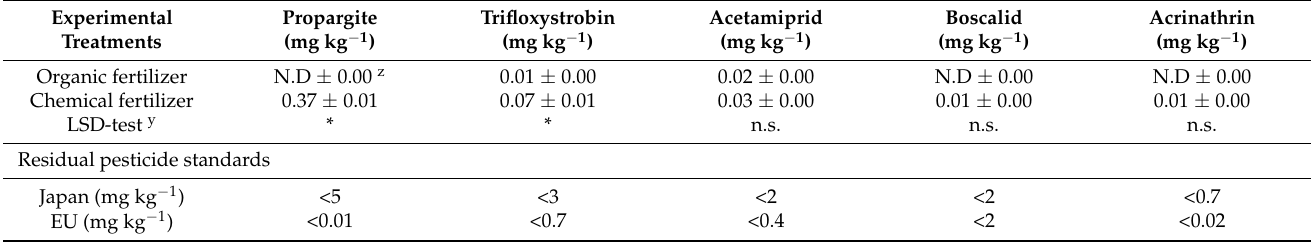
Table 5. Fruit pesticide residues and Japan, European Union (EU), international (Codex), Chinese, and Korean pesticide residue standards. Experimental Treatments Organic